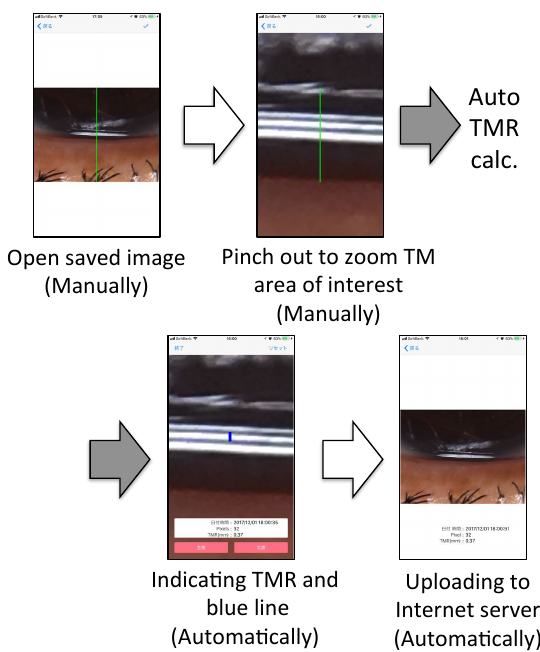
Figure 6. A schematic diagram of TMR calculation process after capturing image.